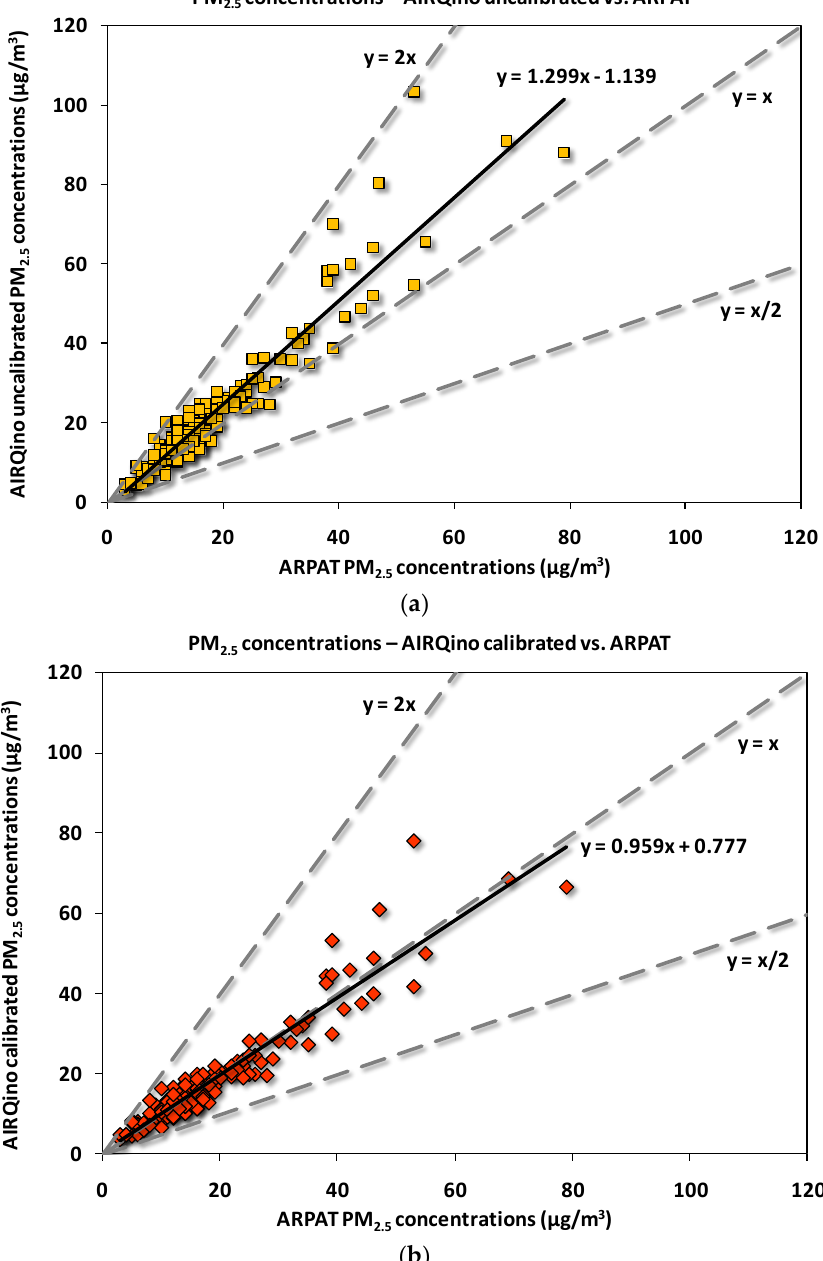
Figure 9. Scatter-plot of 24-h averaged PM 2.5 concentrations (µg/m 3 ) measured in via Bassi (Florence) by AIRQino ( a ) uncalibrated and ( b ) calibrated stations vs. ARPAT reference station (1 November 2016 to 15 April 2017). Dashed lines indicate the perfect agreement between the series (y = x), as well as over-estimation (y = 2x) and under-estimation (y = x/2) by a factor of two.